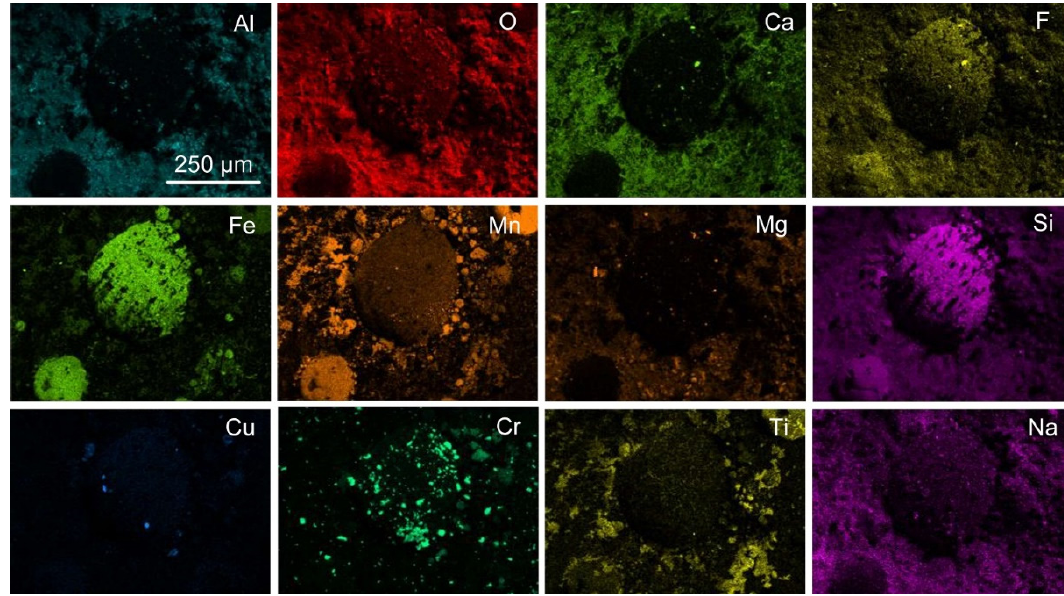
Figure 7. EDX map of marked area in Figure 6b: MP4 slag sample.